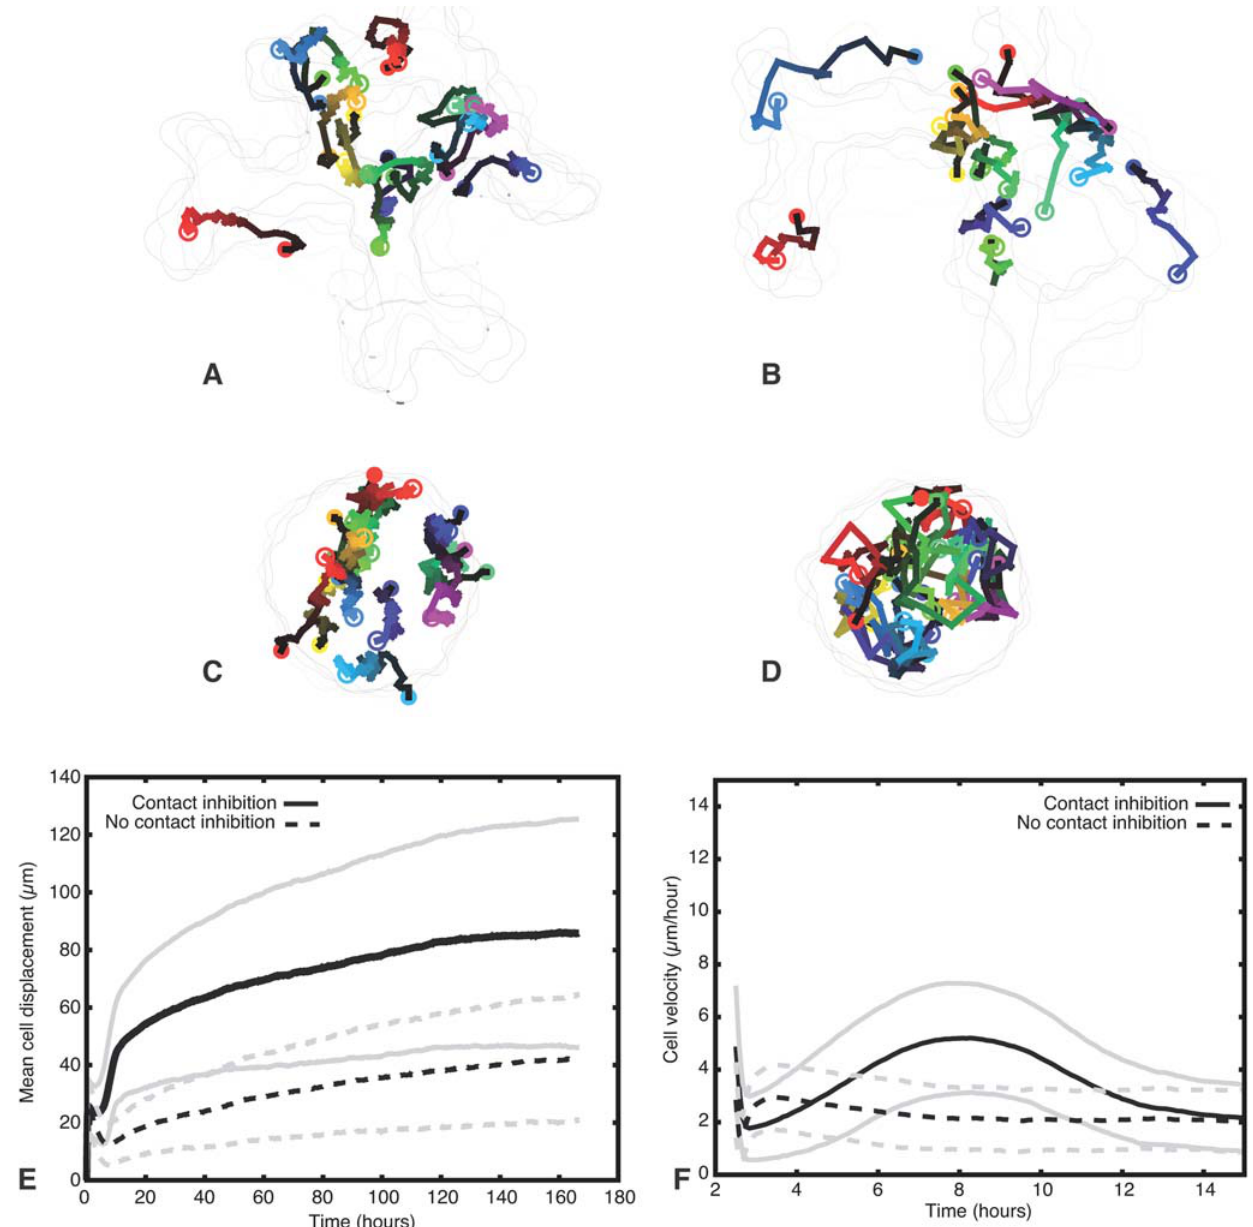
Figure 6. Cell trajectories of simulated endothelial cells in 128-cell clusters in a contact-inhibited, sprouting cluster (A,B) and in a non-contact-inhibited, non-sprouting cluster (C,D). (A,C) Cell trajectories during initial sprouting, indicating the cells’ centers of mass at 100 MCS ( , 50 min) intervals from 100 to 5,000 MCS ( , 1–40 h). (B,D) Cell trajectories after initial sprouting, indicating the cells’ centers of mass at 1,000 MCS ( , 8 h) intervals from 4,000 to 20,000 MCS ( , 30–170 h). Closed circles indicate initial cell positions; open circles indicate final cell positions. Colors identify individual cells; brightness increases from dark (initial positions) to bright (final positions). Outlines of clusters shown at 1000 MCS ( , 8 h) intervals (A,C) or 4000 MCS ( , 33 h) intervals (B,D). (E) Average displacement of cells from original positions over time in 10 simulations with 128 cells each, in contact-inhibited (solid curves) and non-contact-inhibited simulations (dashed curves). Grey curves indicate standard deviations. (F) Cell velocity V i t ð Þ ~ ~ xx i t z D t ð Þ { ~ xx i t { D t ð Þð Þ = 2 D t [19] with D t =300 MCS ( , 2.5 h) for contact-inhibited (solid curves) and non-contact-inhibited (dashed curves) simulations. occurs, and the clusters do not sprout. For small negative surface clusters of 128 cells (256 cells in the Videos). For stronger EC-EC tensions, with values of J ( c , c ) . 2 J ( c , M ), chemotaxis overcomes the adhesion, equivalent to positive surface tension, J ( c , c ) , 2J ( c , M ), the negative surface tension, so ECs still touch each other and sprouts are longer and thinner and the network less compact than sprouting occurs as for zero surface tension, producing thickened for zero surface tension. For very weak EC-EC adhesion J ( c , c ) & 2 J ( c , M ), equivalent to strong negative surface tension, the sprouts and elongated clusters. The insets to Figure 7 and Video S20, S21, S22 show the results for 50 # J ( c , c ) # 70. ECs separate from each other, so contact-inhibition no longer